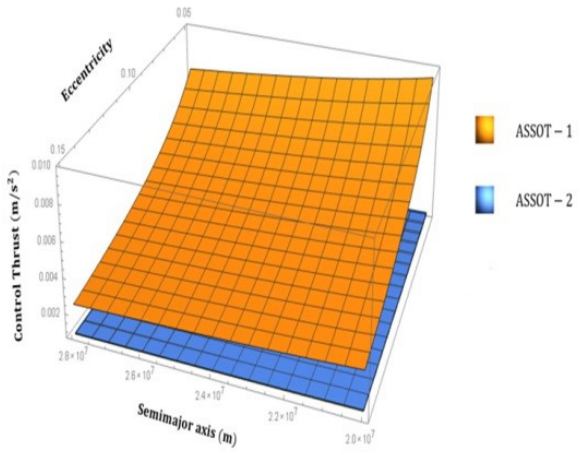
Figure 7. Control thrust vs. semimajor axis and inclination for ASSOT-2 and ASSOT-3